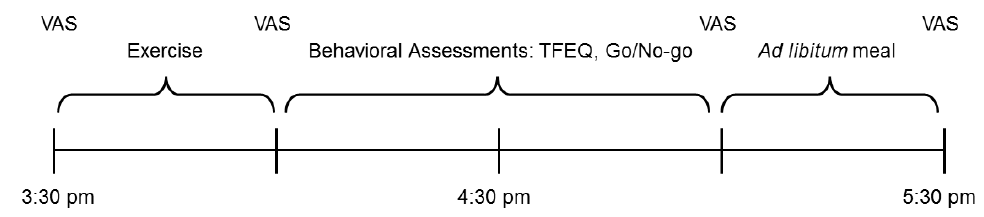
Figure 1. Timeline of study assessments. Visit procedures were identical at Baseline and Year 2. Abbreviations: visual analog scales, VAS; Three-Factor Eating Questionnaire, TFEQ.